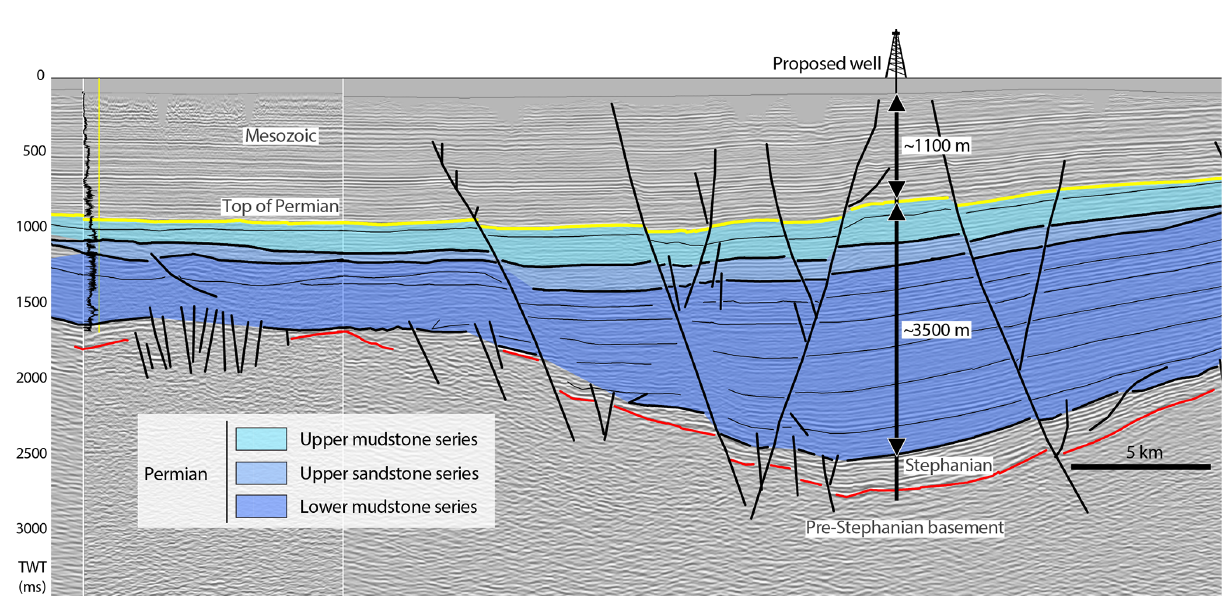
Figure 10. Southwestern Paris Basin (Brécy Basin) seismic line (line of section indicated by fine dotted line in the southern Paris Basin in Fig. 8). Seismic interpretation of lithologies and estimation of thicknesses from the main depocenter in the Brécy area, with a potential drill site indicated by the derrick